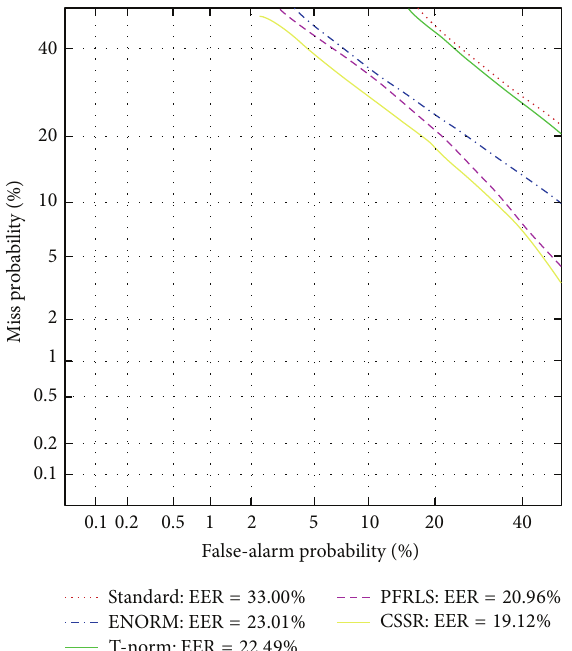
Figure 5: DET curves for the baseline, T-norm, ENORM, PFLSR, and CSSR based speaker verification